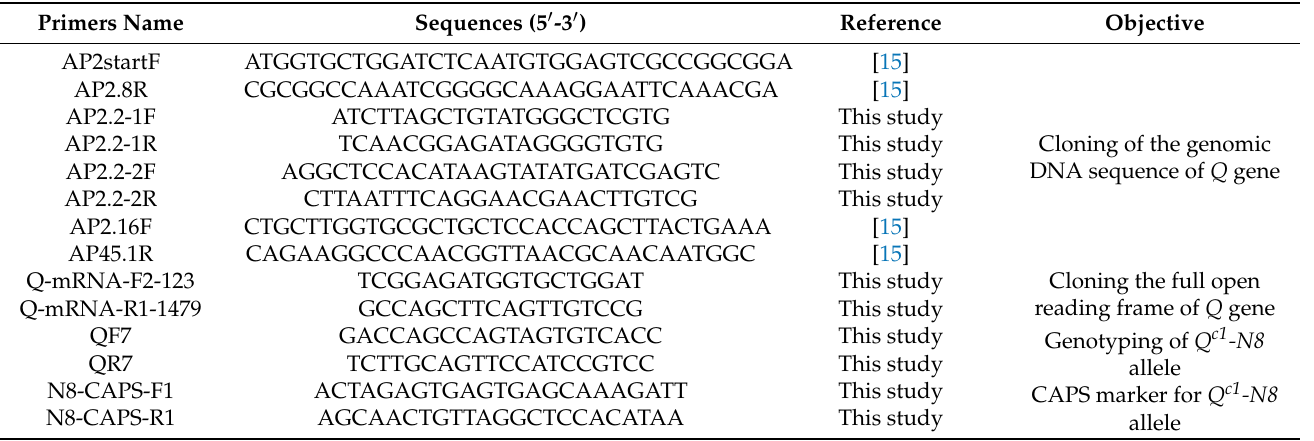
Table 3. Primers used in this